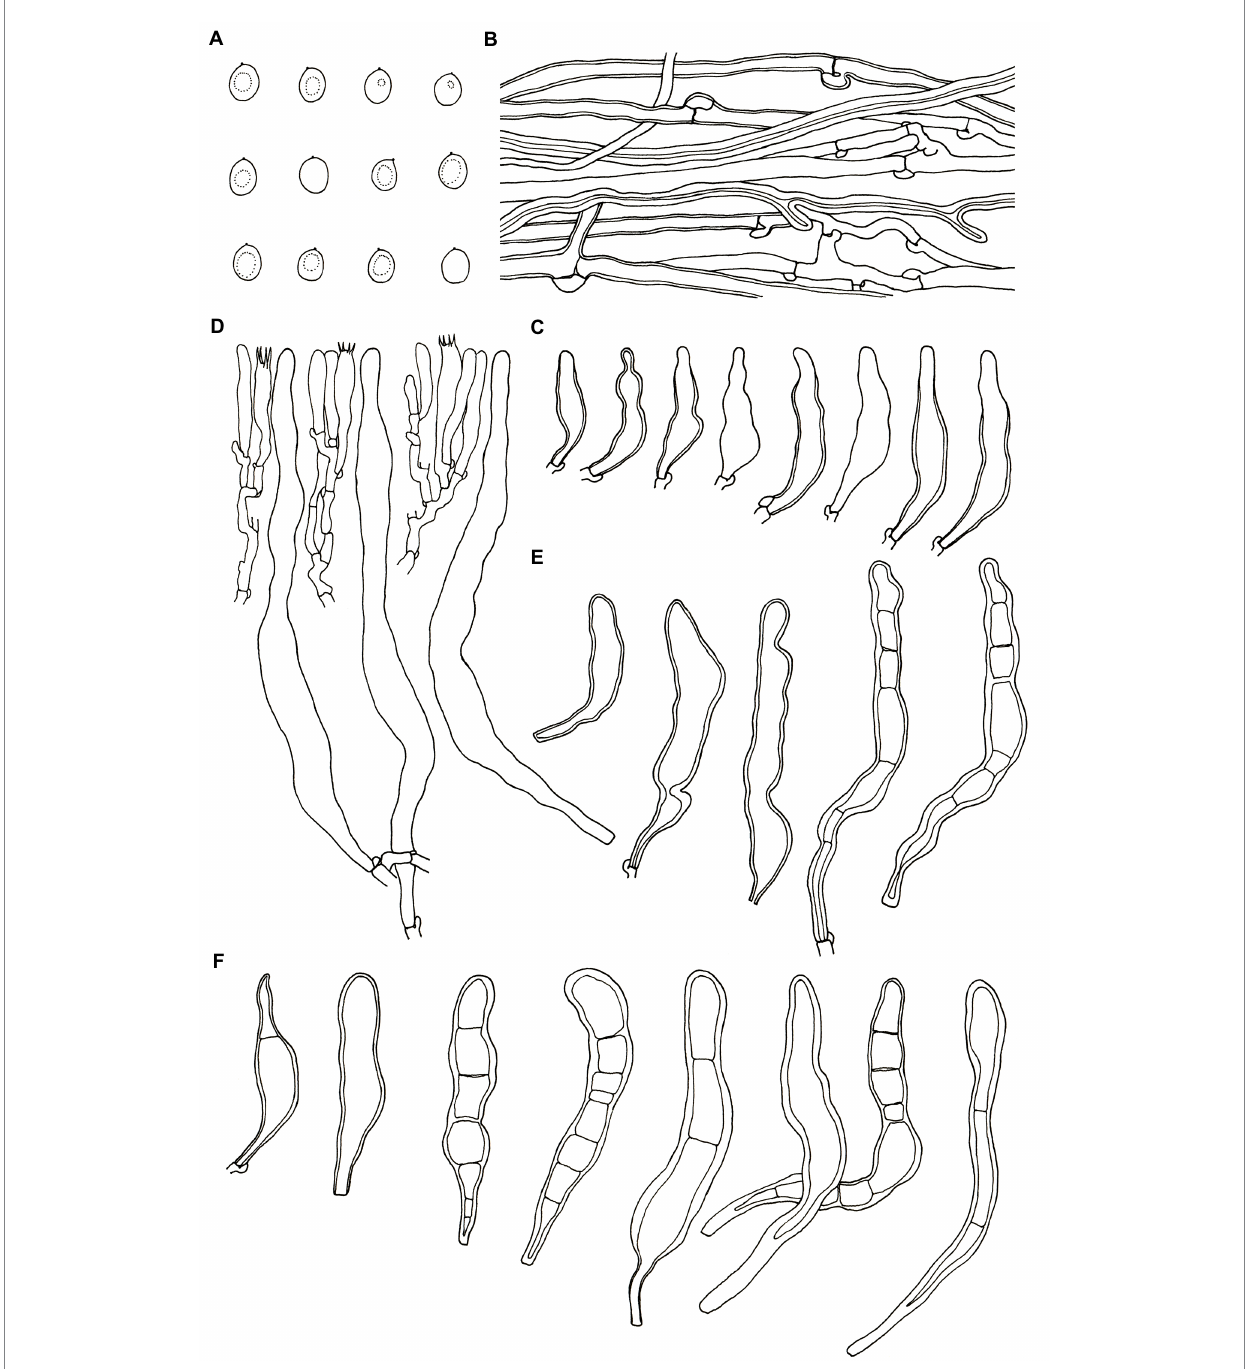
FIGURE 4 Microscopic structures of Podoscypha petalodes subsp. cystidiata (140721–15, holotype). (A) Basidiospores, (B) hyphae from context, (C) cystidia, (D) basidia, basidioles, and gloeocystidia from the hymenium, (E) pilocystidia, and (F) caulocystidia. (Bars: (A) = 5 μ m, (B–F) = 10 μ m). Drawn by Hai-Jiao